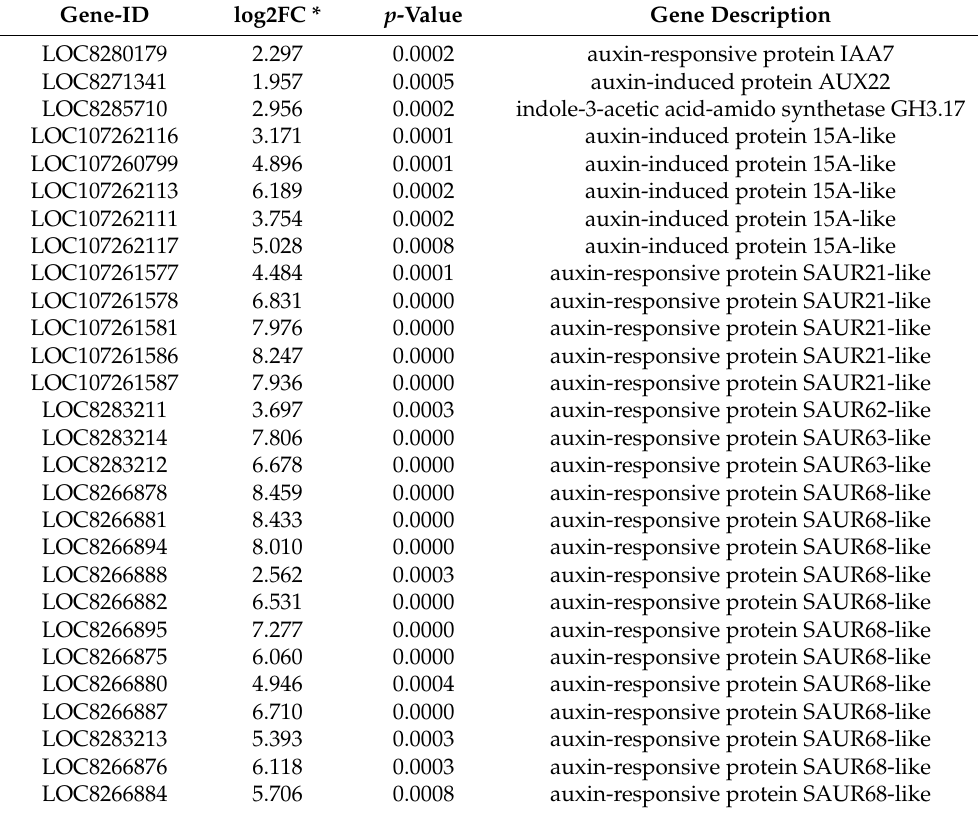
Table 1. Genes known to be involved in auxin signaling or earlier auxin response are enriched in the first internode of stem compared to upper hypocotyl of accession line